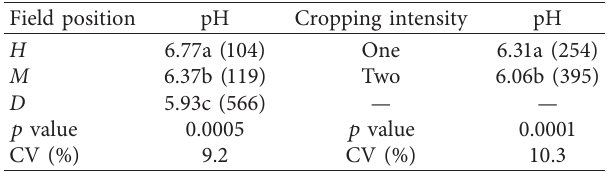
Table 6: Soil pH level under farmers’ soil types and on fields owned by farmers with different wealth statuses.